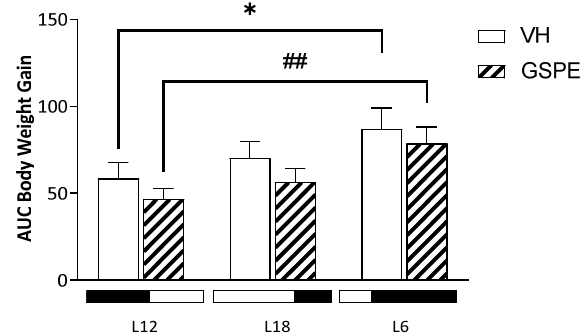
Figure 1. Body weight gain as area under the curve (AUC) of Fischer 344 rats treated with VH or GSPE exposed to standard (12 h light:12 h dark), long (18 h light:6 h dark), or short (6 h light:18 h dark) photoperiods fed with STD diet ( n = 8). The results are presented as the mean ± SEM. * indicates significant differences within VH groups (Student’s t test, * p < 0.05); # indicates significant differences within GSPE groups (Student’s t test, ## p < 0.01).